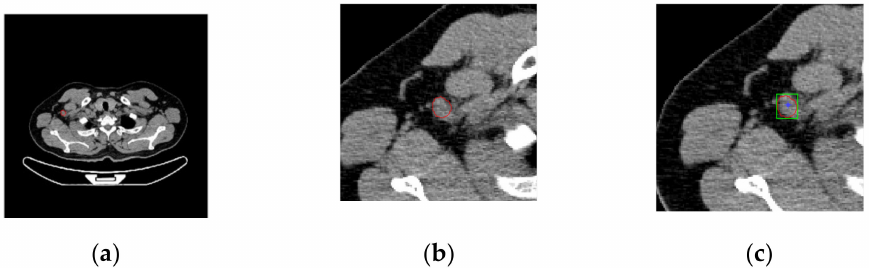
Figure 10. Labeling of lesion segmentation. ( a ) Delineated lesion on the CT image. ( b ) Local enlarged view of delineated focus. ( c ) Divide the lesion with a rectangular box.